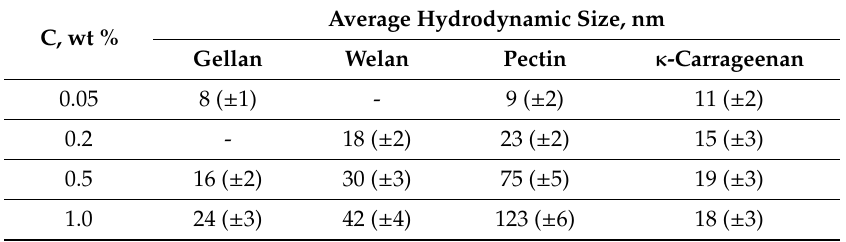
Table 3. Influence of the concentration of natural polymers on the average hydrodynamic size of AuNPs. The standard deviations are given in parentheses.